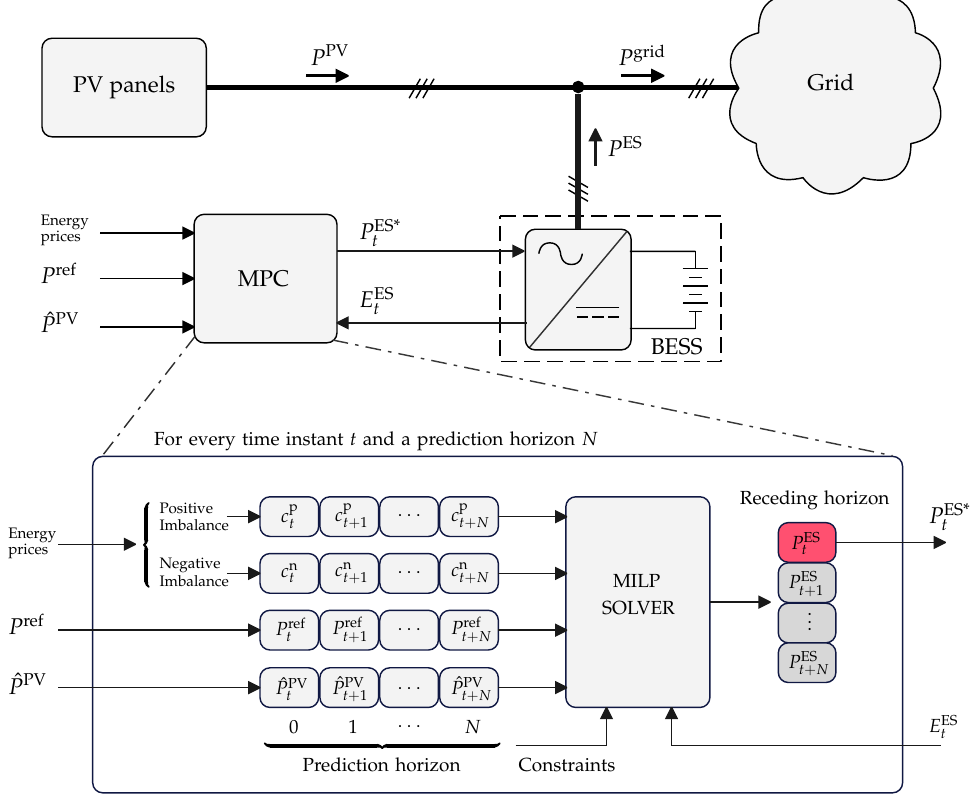
Figure 1. Model predictive control